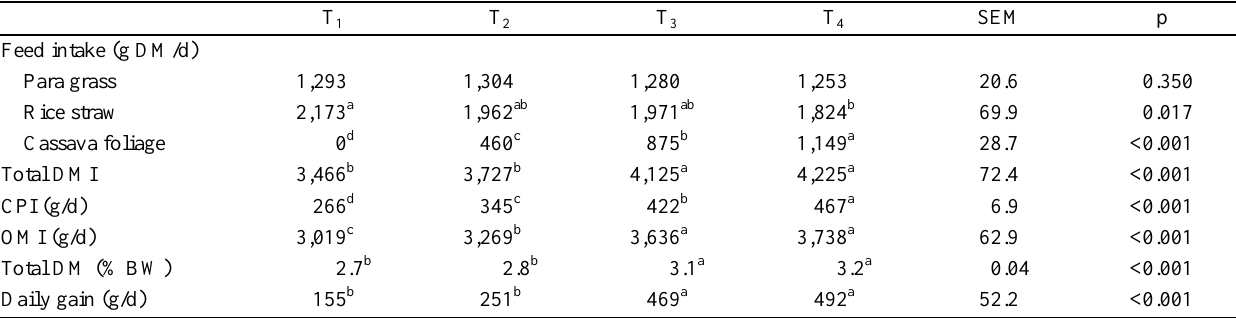
Table 2. Mean values of feed and nutrient intake and daily weight gain of cattle fed different diets T 1 T 2